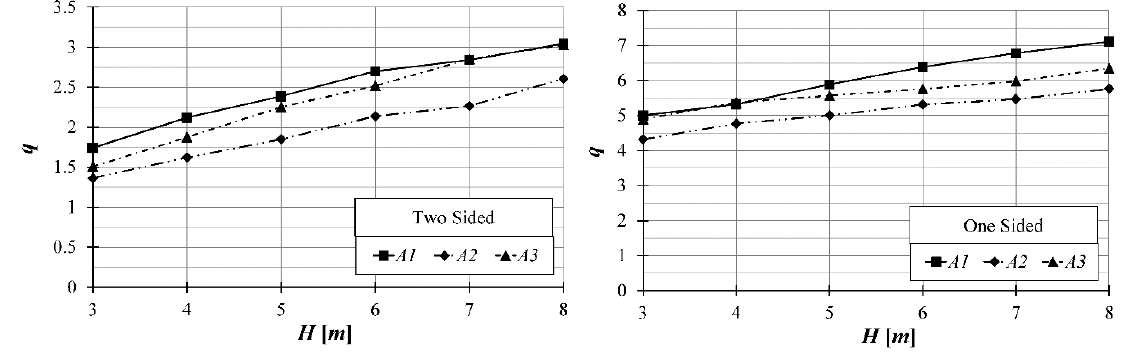
Figure 8. Force reduction factor q versus height H —Unreinforced block, α =7.5°.